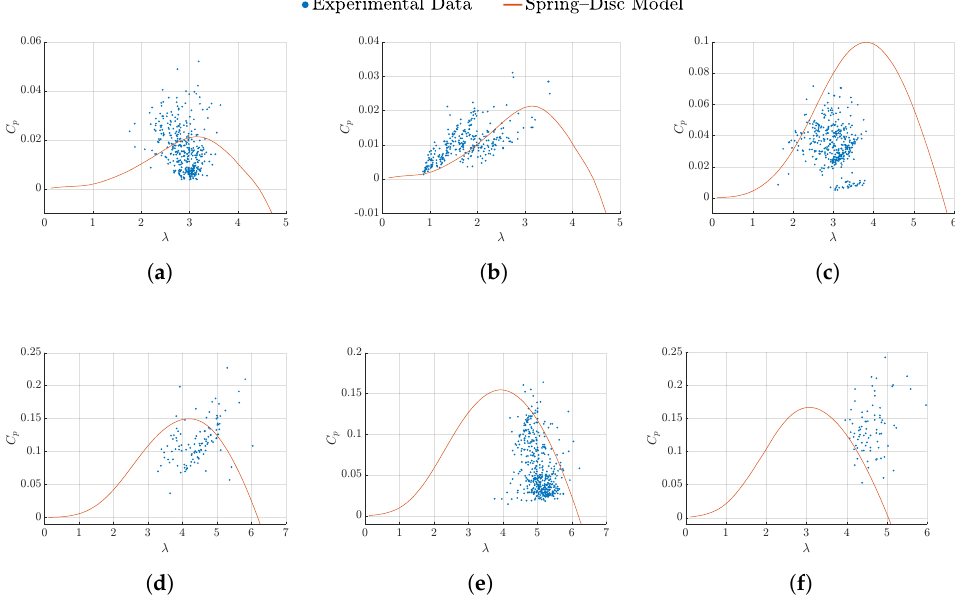
Figure 11. Power coefficient against tip speed ratio for various Daisy Kite configurations using the steady-state spring-disc model compared to experimental data. ( a ) Soft wing TRPT − 1; ( b ) Soft wing TRPT − 2; ( c ) Soft wing TRPT − 3; ( d ) Rigid wing TRPT − 3; ( e ) Rigid wing TRPT − 4; ( f ) Rigid 6 − wing TRPT −